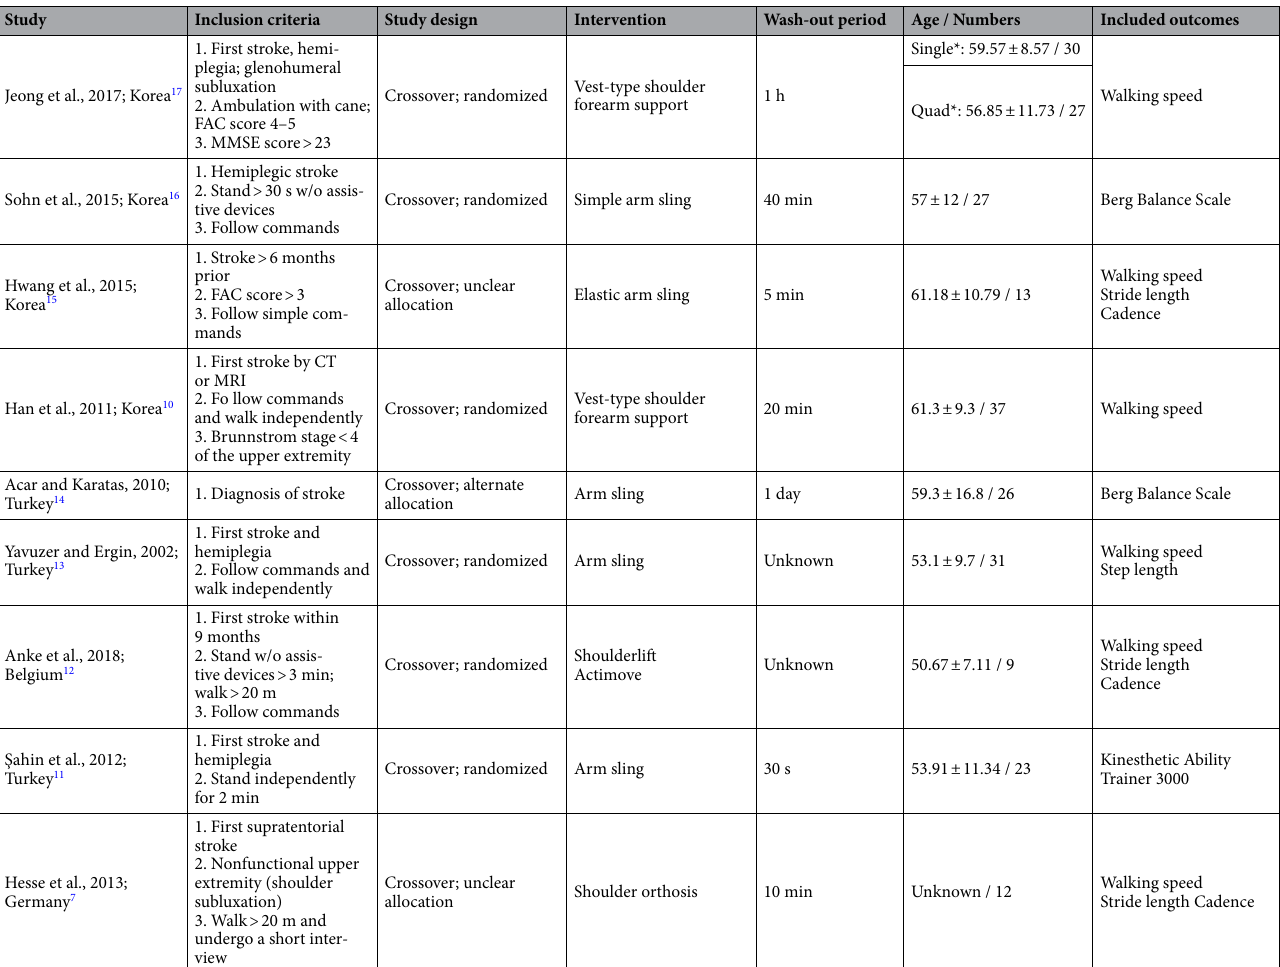
Table 1. Characteristics of included trials. FAC, Functional Ambulation Category; MMSE, Mini Mental State Examination; CT, computed tomography; MRI, magnetic resonance imaging; w/o, without; Single*, Single- cane users; Quad*, quad-cane users; min, minutes; m, meter.